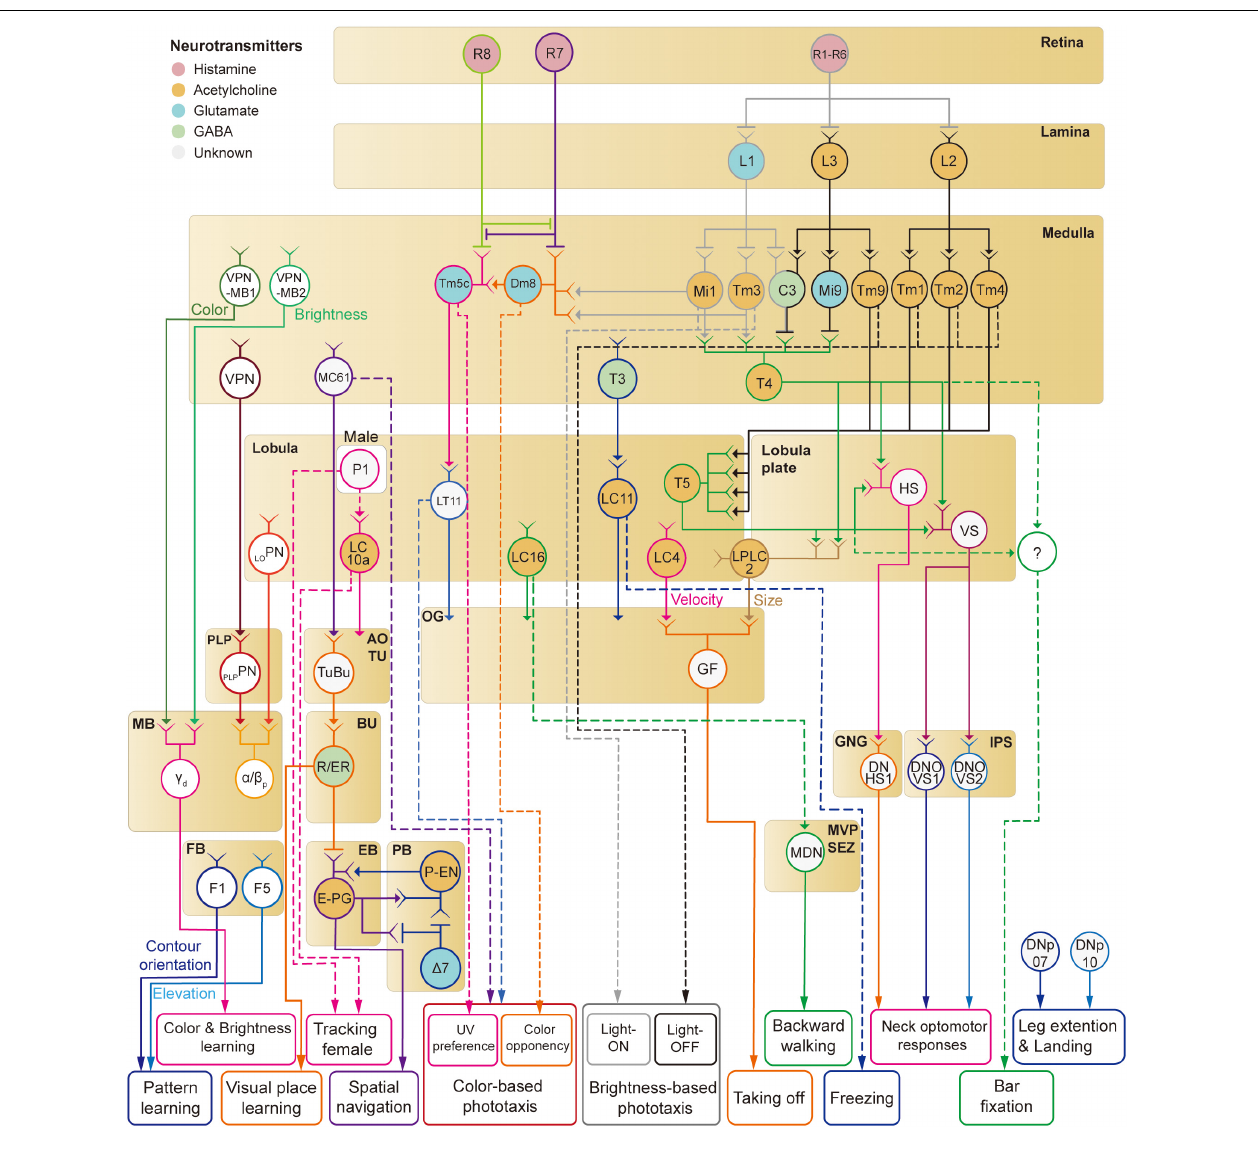
FIGURE 8 | A schematic diagram of neural circuits involved in visual feature-based behaviors in Drosophila .